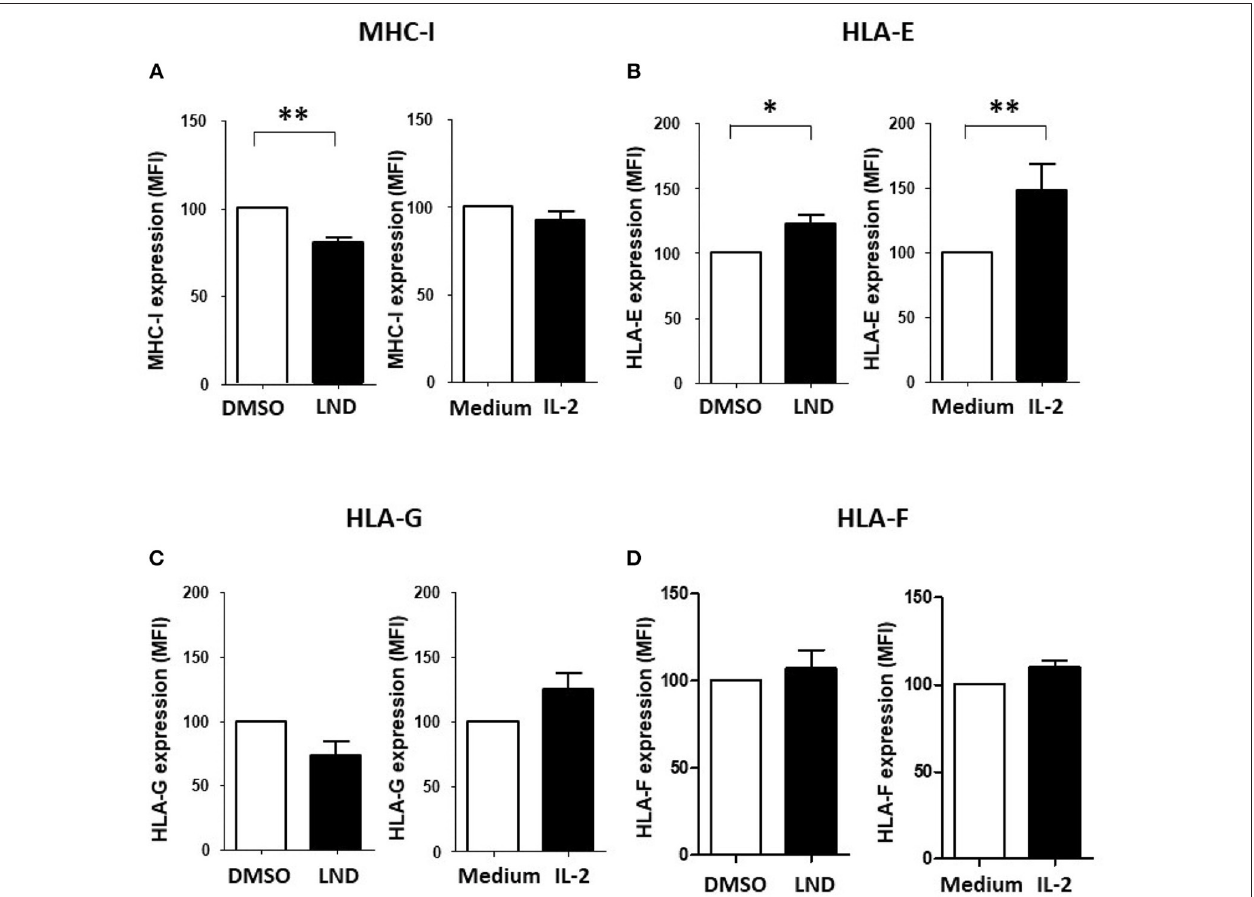
FIGURE 4 | Effect of lenalidomide and IL-2 on the expression of ILT2 ligands on leukemic cells. The effect of lenalidomide (LND; 1 µ M) and IL-2 (50 U/mL) on the expression of classical and non-classical MHC class I molecules on leukemic cells was analyzed by flow cytometry in PBMCs obtained from 10 CLL patients. The figure shows the comparison of the expression of MHC class I (A) , HLA-E (B) , HLA-G (C), and HLA-F (D) on leukemic cells treated with both drugs. SEM, Standard Error of the Mean; Wilcoxon Matched-Pairs Signed Ranks test; * P < 0.05, ** P <